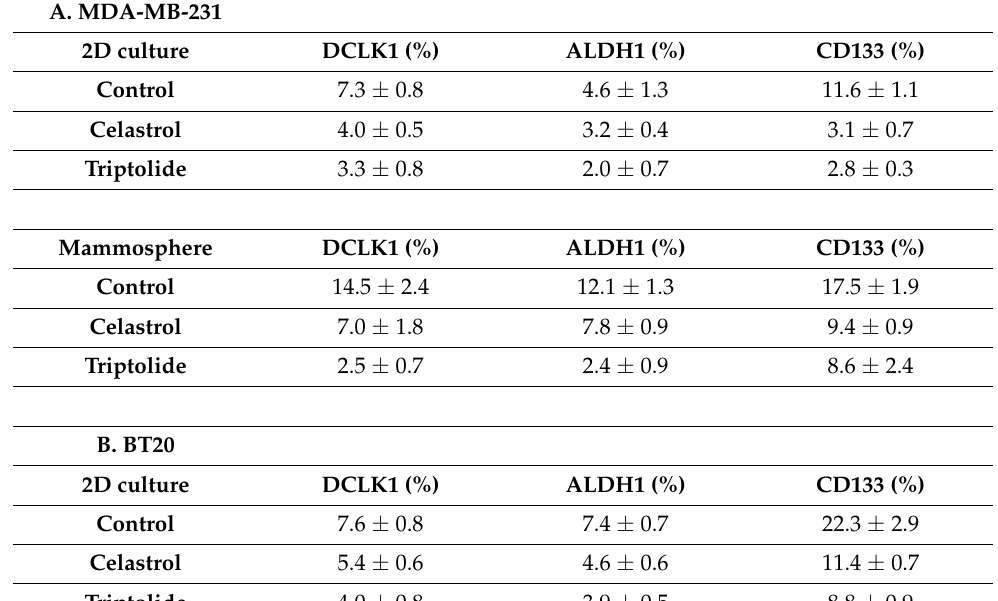
Table 2. Celastrol and triptolide affect CSCs in TNBC cells compared with 2D vs. primary mammo- sphere. Mammosphere culture shows a greater number of DCLK1, ALDH1, and CD133 positive cells when compared to the control in MDA-MB-231, BT20, and PD-TNBC cells. ( A , B ) Triptolide-treated mammosphere shows greater reduction in DCLK1 and ALDH1 positive cells, but not in CD133 positive cells when compared to 2D culture. ( C ) Celastrol and triptolide show no difference in DCLK1 and CD133 positive cells between 2D and mammosphere culture. ALDH1 positive cells show a significant decrease in triptolide-treated mammosphere when compared to 2D